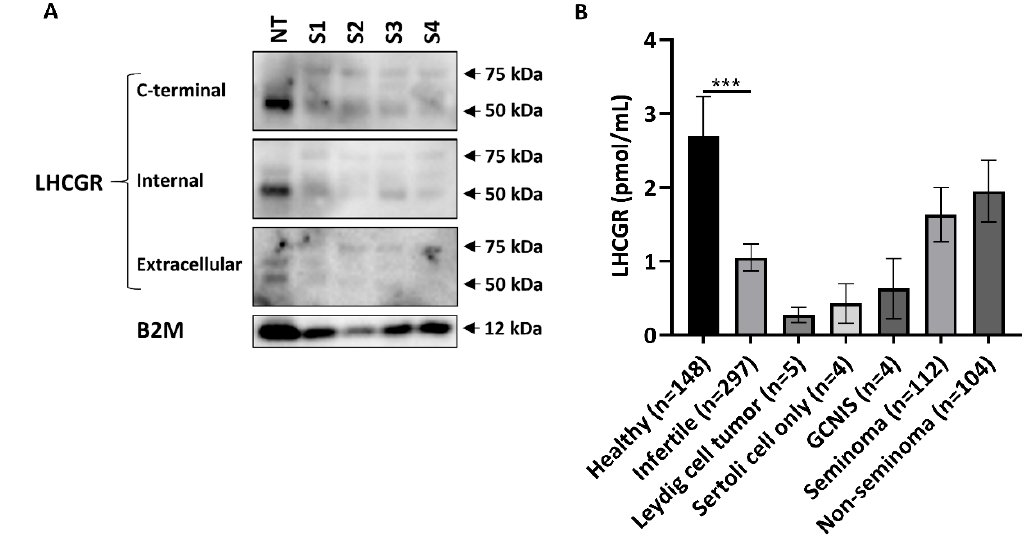
Figure 3. LHCGR in serum from patients with TGCTs. ( A ) Western blot analysis of serum LHCGR. NT: normal testis tissue from a patient with GCNIS. S1: serum from a healthy man with low LHCGR. S2: serum from a healthy man with high LHCGR. S3: serum from a patient with seminoma and high serum LHCGR. S4: serum from a patient with non-seminoma and high serum LHCGR. Serum levels of LHCGR were measured by a validated ELISA platform. B2M was used as loading control. ( B ) LHCGR serum levels analyzed using a LHCGR ELISA in men with non-malignant conditions and TGCTs. Values represent mean ± SEM. *** p < 0.001 compared with healthy controls. Abbreviations: B2M, beta-2-microglobulin; GCNIS, germ cell neoplasia in situ; LHCGR, luteinizing hormone/choriogonadotropin receptor.